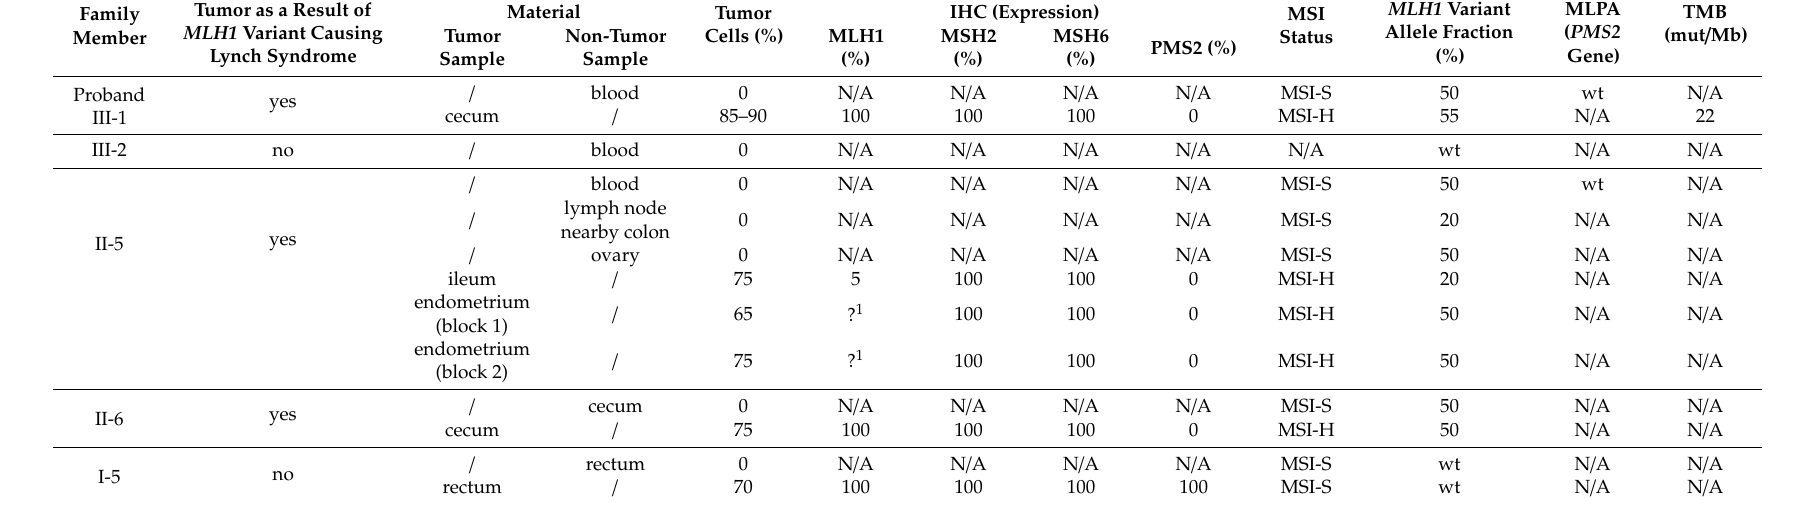
Table 1. Testing for Lynch syndrome: characterization and segregation analysis in available family